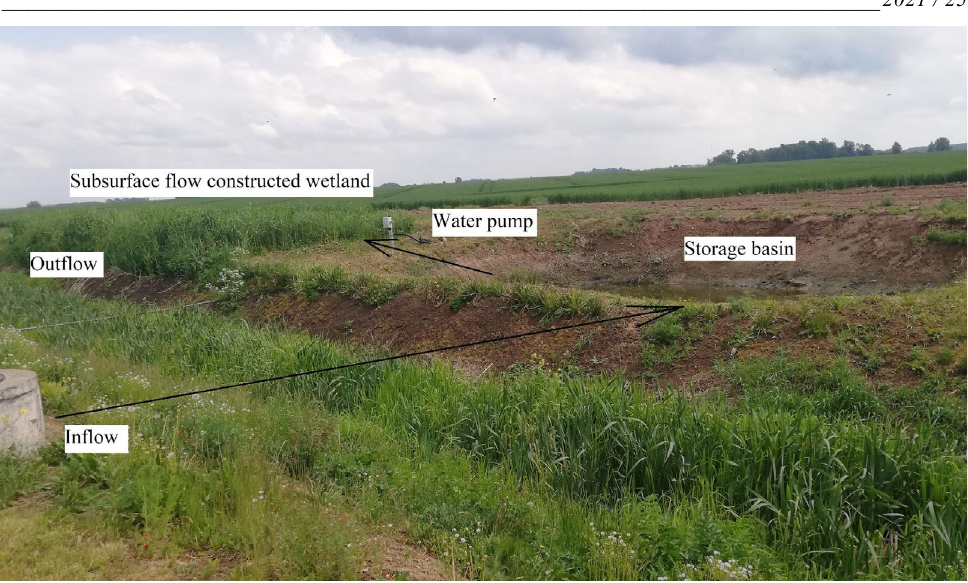
Fig. 2. A storm water treatment system with horizontal subsurface slow constructed wetland at the Mezaciruli farm. Photograph taken by the